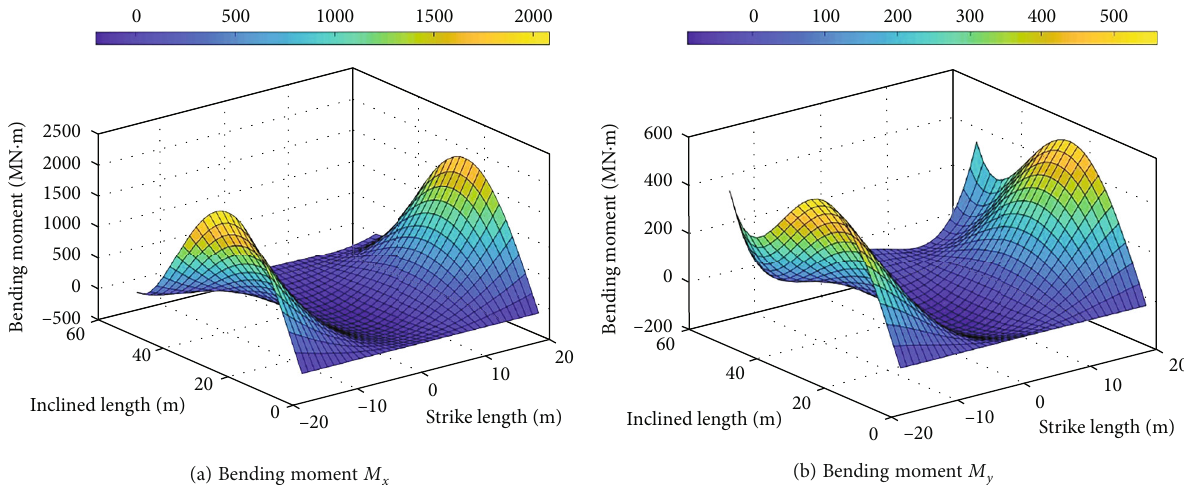
Figure 11: Bending moment of roof model with three sides fi xed and one side simply supported (the simply supported side is the short